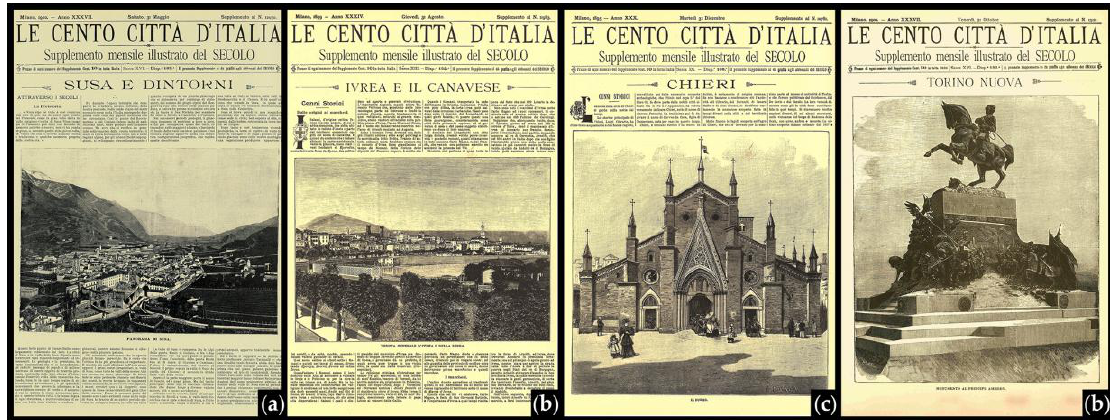
Figure 2. Examples of different representation scales of the images in the first page: ( a ) territorial; ( b ) urban; ( c ) architectural; ( d )